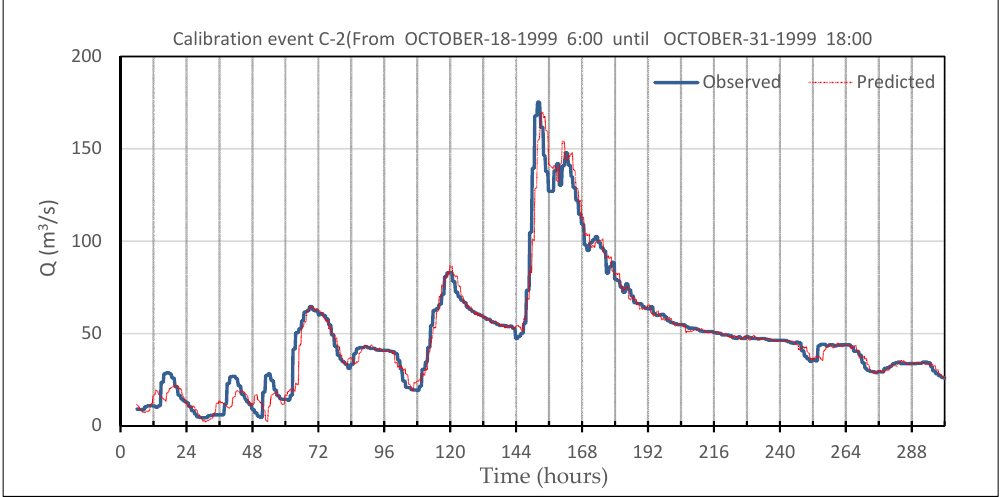
Figure 7. Comparison of flow forecasts and observed outflows at the Graus station (calibration event C-2).